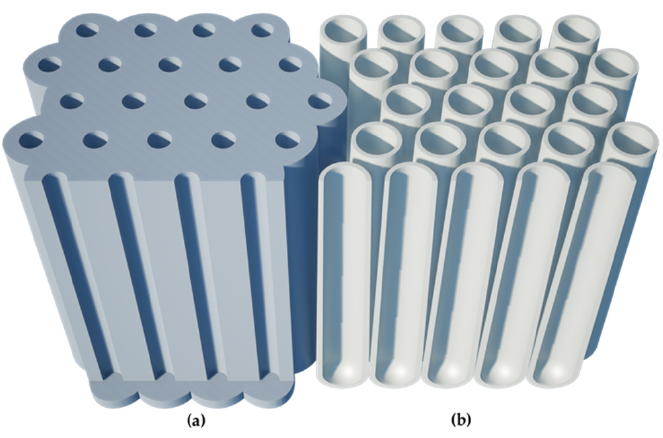
Figure 2. Schematic representation of ( a ) of nanopores NP and ( b ) nanotubes. It is well known that cell behavior is sensitive to surface characteristics such as chemical and physical features [5] and to surface topography and surface reactivity, also EA seems to enhance fibroblast/epithelial response and cell functions. This trend was highlighted by the first in vitro studies investigating fibroblast and epithelial cell response on anodized titanium surfaces [1,6]. However, due to the lack of reproducibility, it remains very difficult to understand the real impact of these surface characteristics on the soft tissue’s response. Although in vitro studies cannot explain the complex interactions which occur in the human body, it remains an interesting investigation since it allows precise understanding of the influence of one parameter on a cell